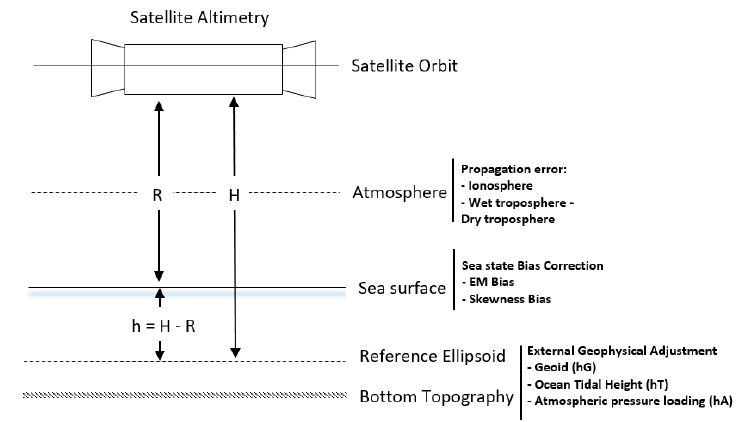
Figure 1. Graphic illustration of satellite altimetry height measurement principle (adapted from [40]).